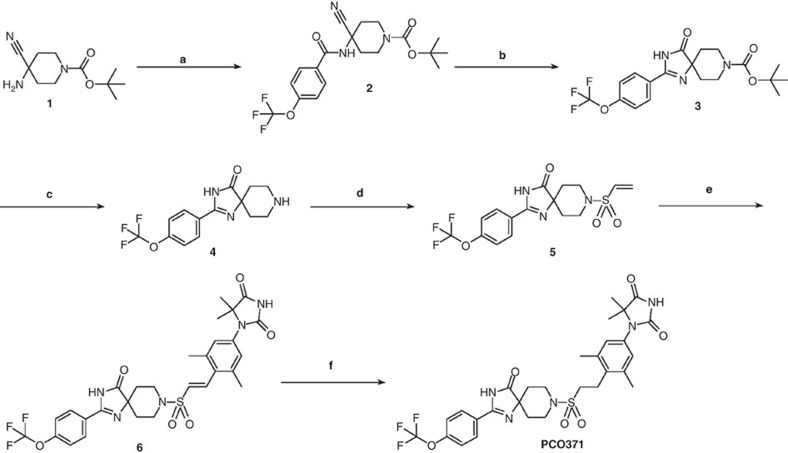
Synthesis of PCO371.Reagents and conditions: (a) 4-trifluoromethoxybenzoic acid, HATU, DIPEA and DMF, room temperature; (b) 30% H2O2 aq., 2 mol l−1 NaOH aq., EtOH, room temperature, then 5 mol l−1 NaOH aq., 50 °C; (c) 4 mol l−1 HCl in dioxane, CH2Cl2, room temperature; (d) 2-chloroethane-1-sulfonyl chloride, Et3N, CH2Cl2, room temperature. (e) 1-(4-bromo-3,5-dimethylphenyl)-5,5-dimethylimidazolidine-2,4-dione, Pd(dba)2, t-Bu3P-HBF4, methyl dicyclohexylamine, NMP, 100 °C; (f) 20% Pd(OH)2/C, H2, DMF–MeOH–MeCN, room temperature.